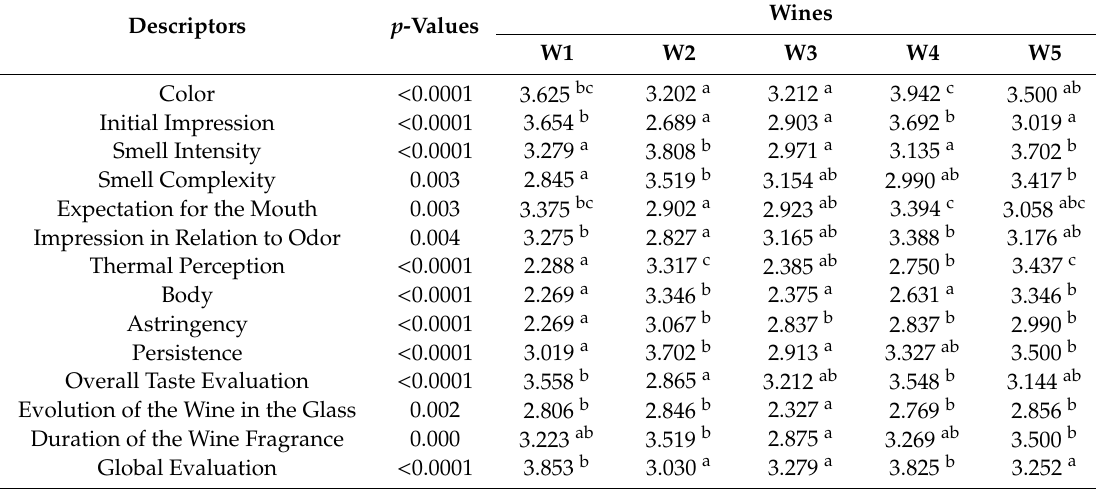
Table 4. Estimated mean values of each attribute of the tasting sheet for wines W1 to W5 by the consumer